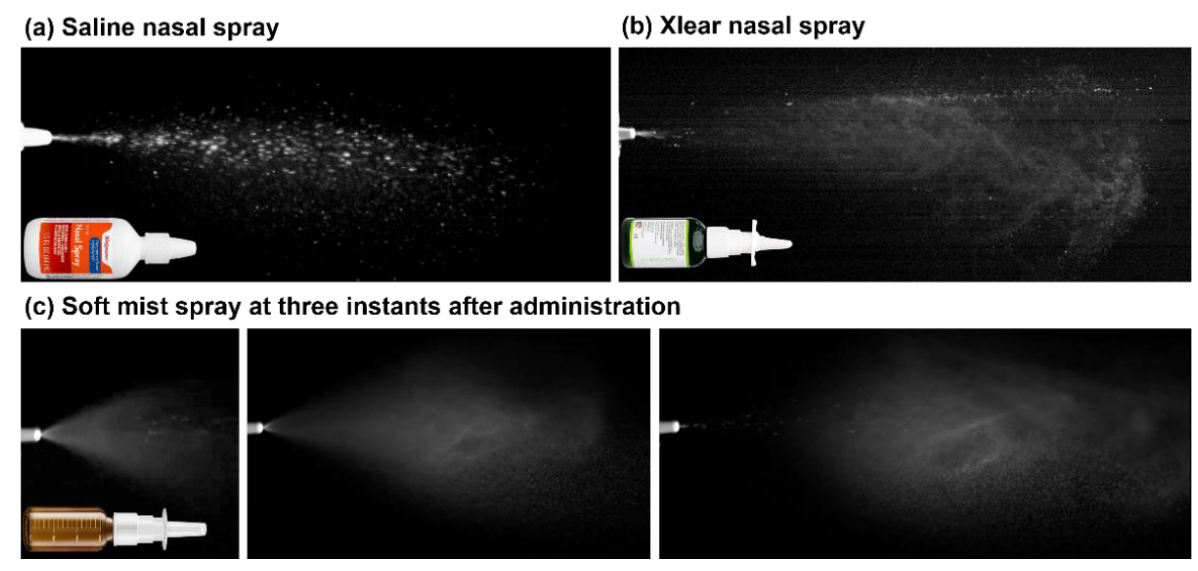
Figure 2. High-speed imaging of the three types of nasal sprays: ( a ) saline nasal spray, ( b ) Xlear, and ( c ) soft-mist spray (at three instants after administration).